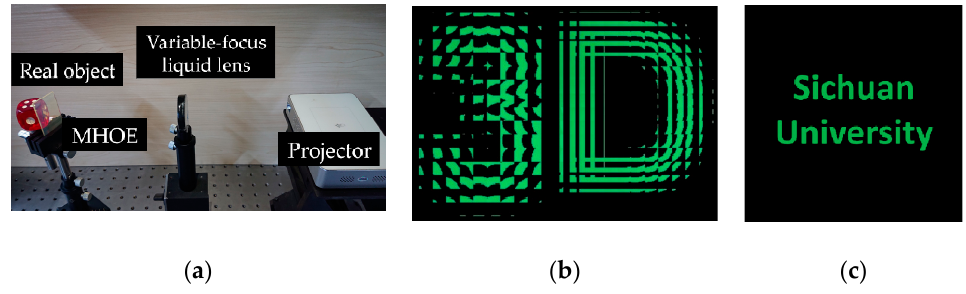
Figure 7. ( a ) Experimental system; ( b ) elemental image array; ( c ) 2D image. On the 3D display mode, the projected beam meets the Bragg diffraction condition 1. The 3D image is reconstructed, and four different perspectives from top left, top right, bottom left and bottom right viewing points are shown in Figure 8a. Obvious horizontal and vertical parallaxes can be clearly seen. Additionally, the character “3” is bigger than letter “D”, which demonstrates that “3” is reconstructed in front of the MHOE while “D”